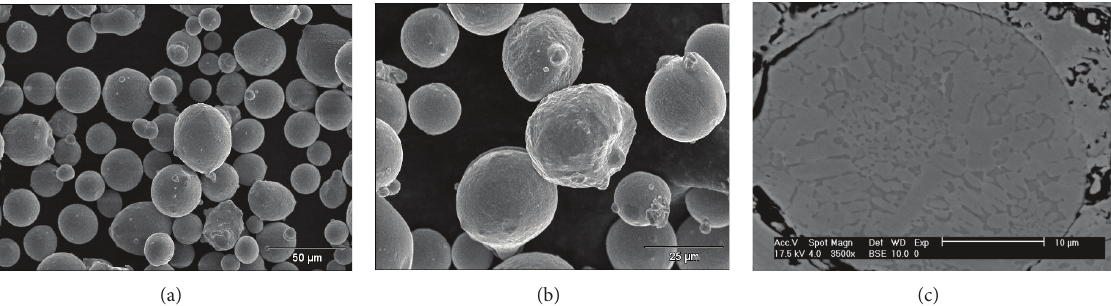
Figure 1: Co 32 Ni 21 Cr 8 Al 0.5 Y powder micrograph by SEM. (a) and (b) morphology and (c) cross-section.